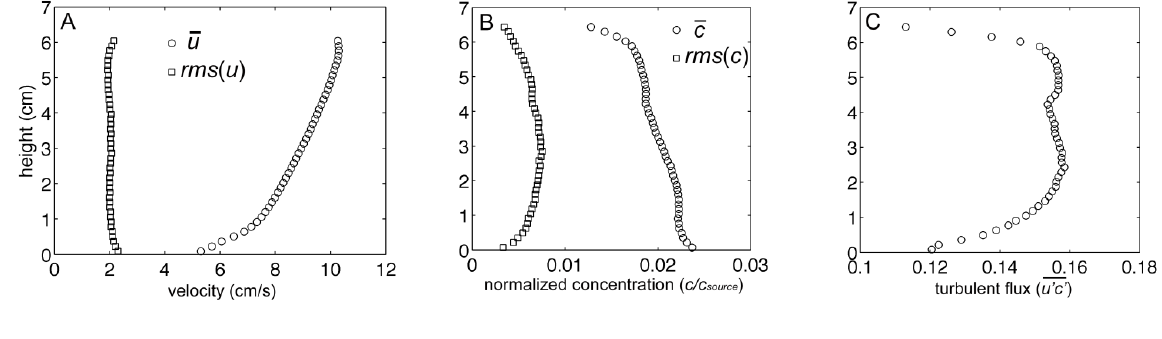
Figure 5. ( A ) Mean and fluctuating components of horizontal velocity within the laboratory flume from PIV. Fluctuating component computed as the root mean square ( rms ) of the horizontal velocity; ( B ) Mean and rms fluctuating component of normalized concentration from PLIF; ( C ) Mean horizontal turbulent flux (g cm −2 s −1 ), computed as mean of the fluctuating horizontal velocity, u’ , (in cm s −1 ), multiplied by the fluctuating normalized concentration, c’